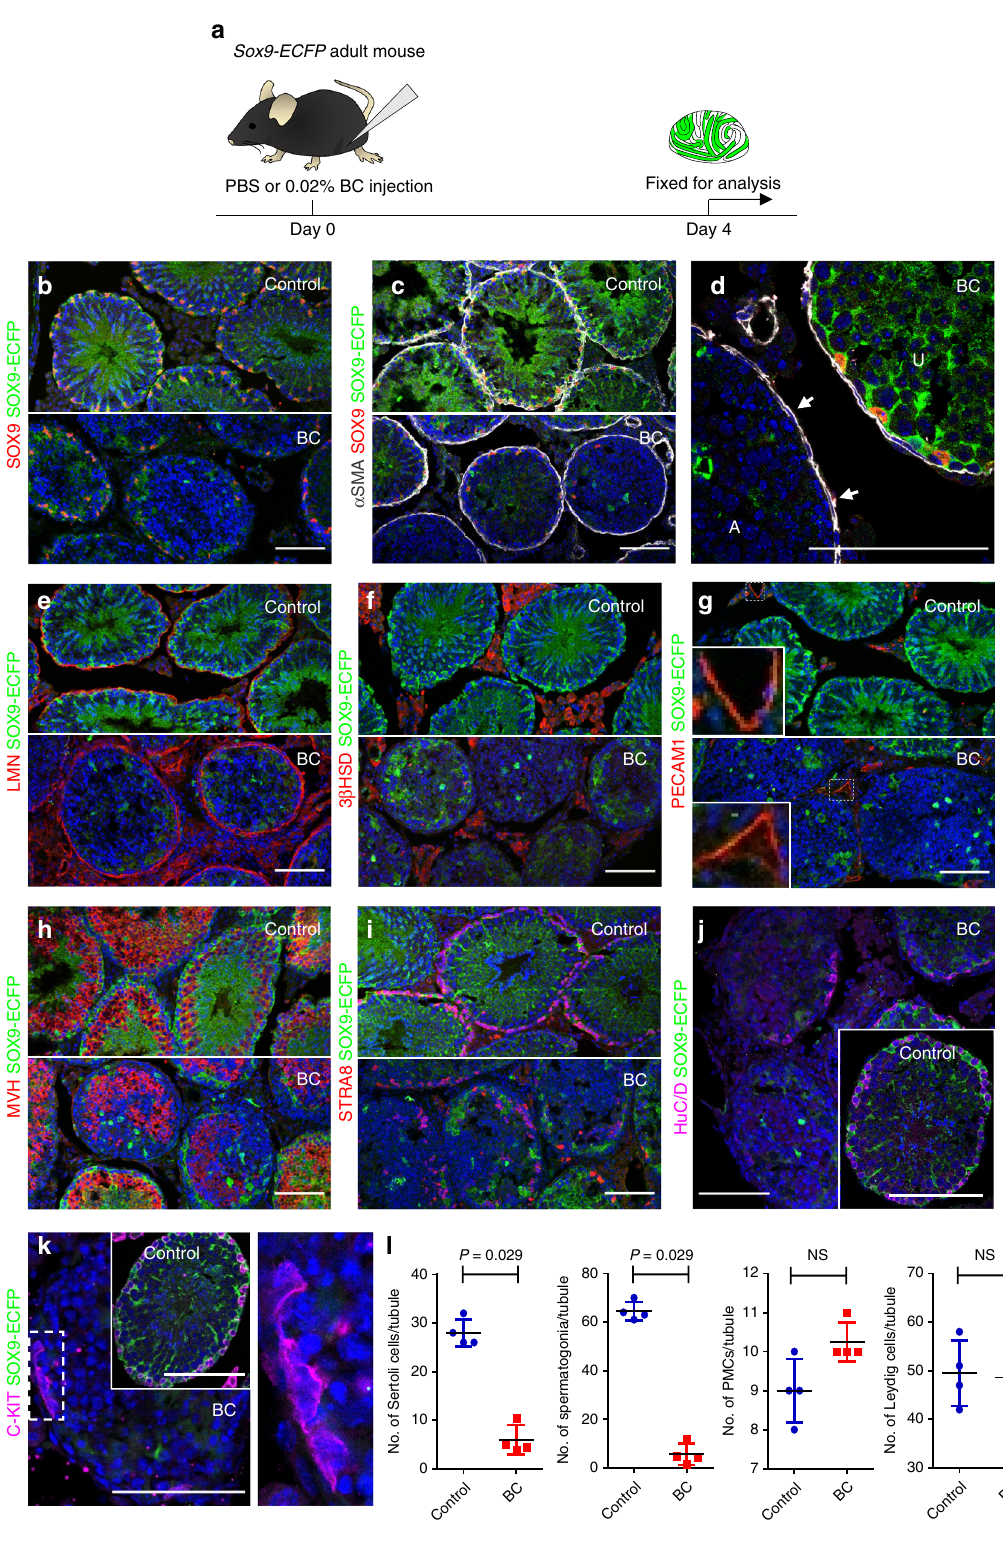
Analysis of affected testis tubules on day 3 showed defects in the differentiating germ cell layer, with many irregularly condensed nuclei (Supplementary Fig. 3e, f). Cleaved Caspase 3 + cells were rarely seen on day 3 (Supplementary Fig. 3e), but some cells, presumably spermatocytes, were positive for Caspase 3 on day 4 (Supplementary Fig. 3g). There was evidence for accumulation